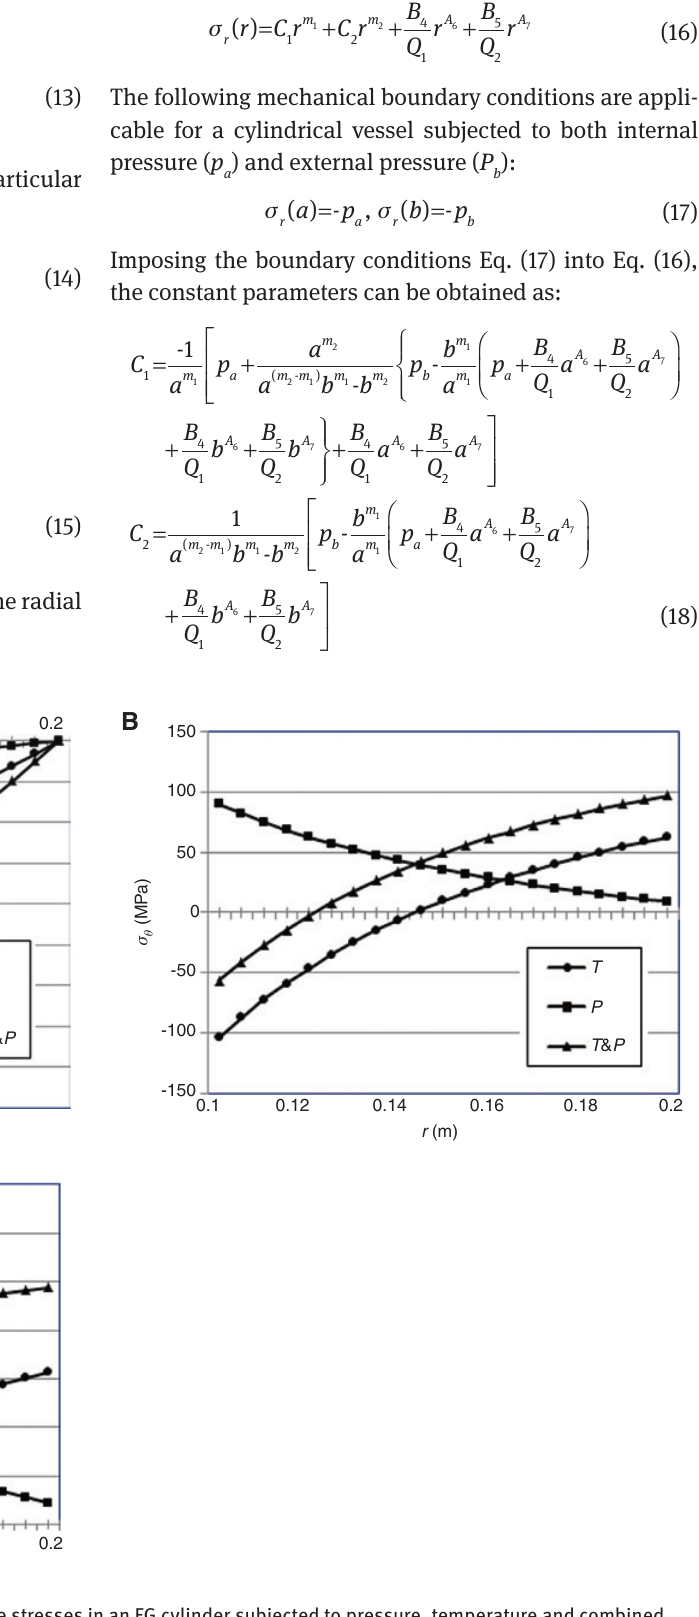
= 40 MPa, p = 0, T = 400 ° K, T = 300 ° a b a b